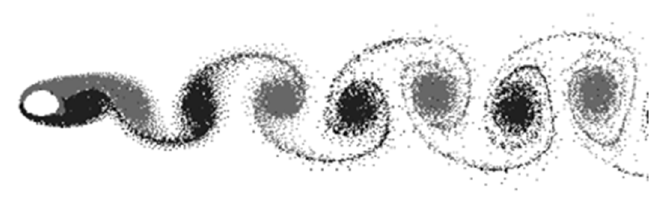
Figure 1. Schematic of the vortex street.